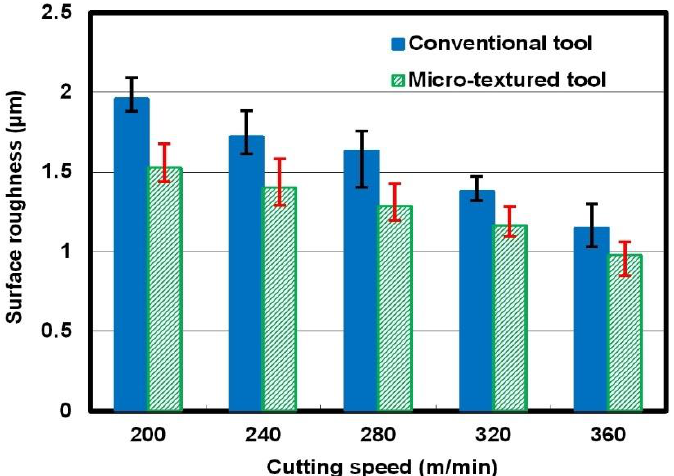
Figure 4. Surface roughness of the finished workpiece at different cutting speeds.